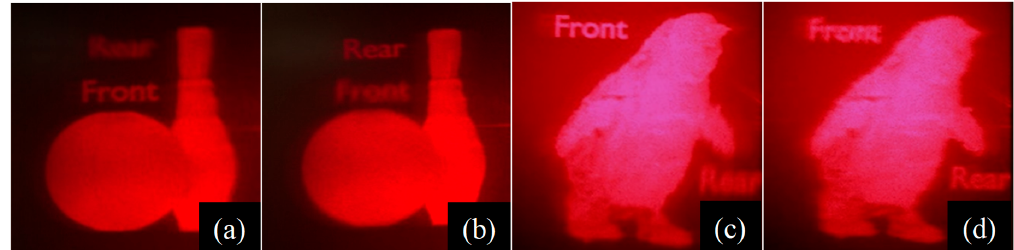
Figure 10. Optical reconstruction of captured information with holograms. Captured hologram of simulated light field focused on ( a ) Front (Video S1. 3D reconstruction of simulated object) and ( b ) Rear. Captured hologram of the captured light field focused on ( c ) front (Video S2. 3D reconstruction of captured object) and ( d ) rear.